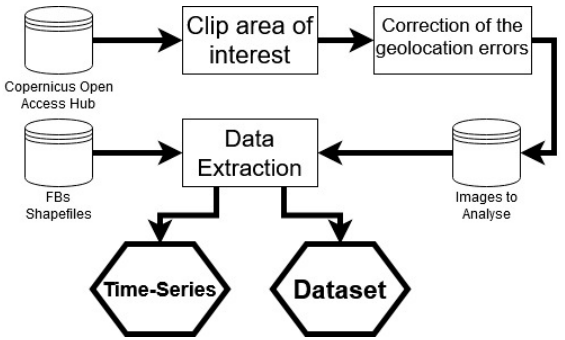
Figure 8. Diagram of the data extraction stage.